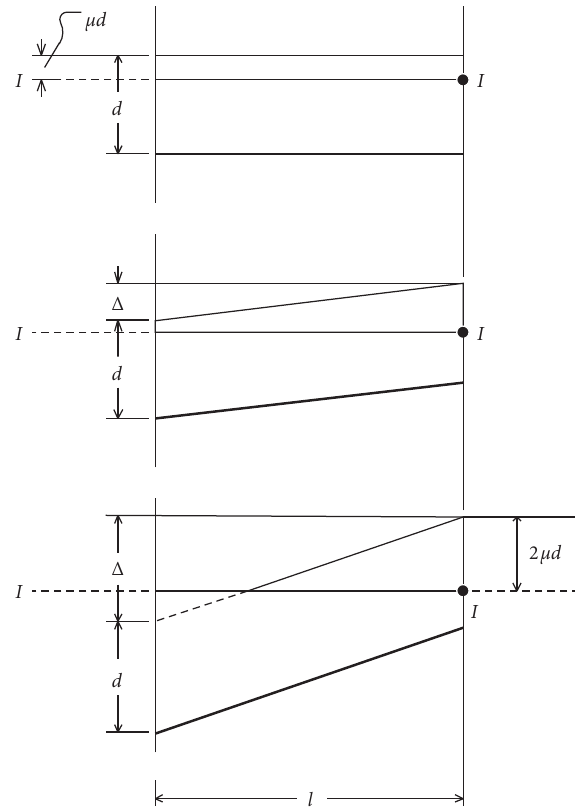
Figure 4: Area diagrams for fully clamped RC